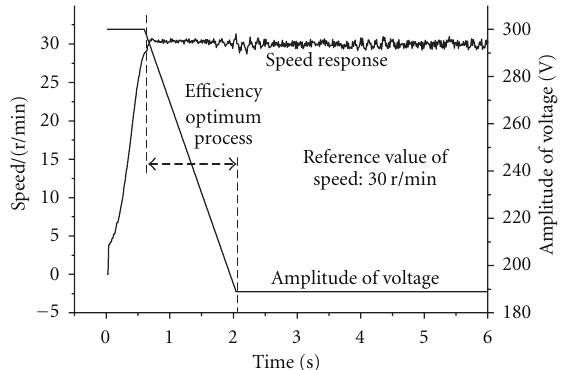
Figure 6: Speed response with e ffi ciency optimum and fuzzy